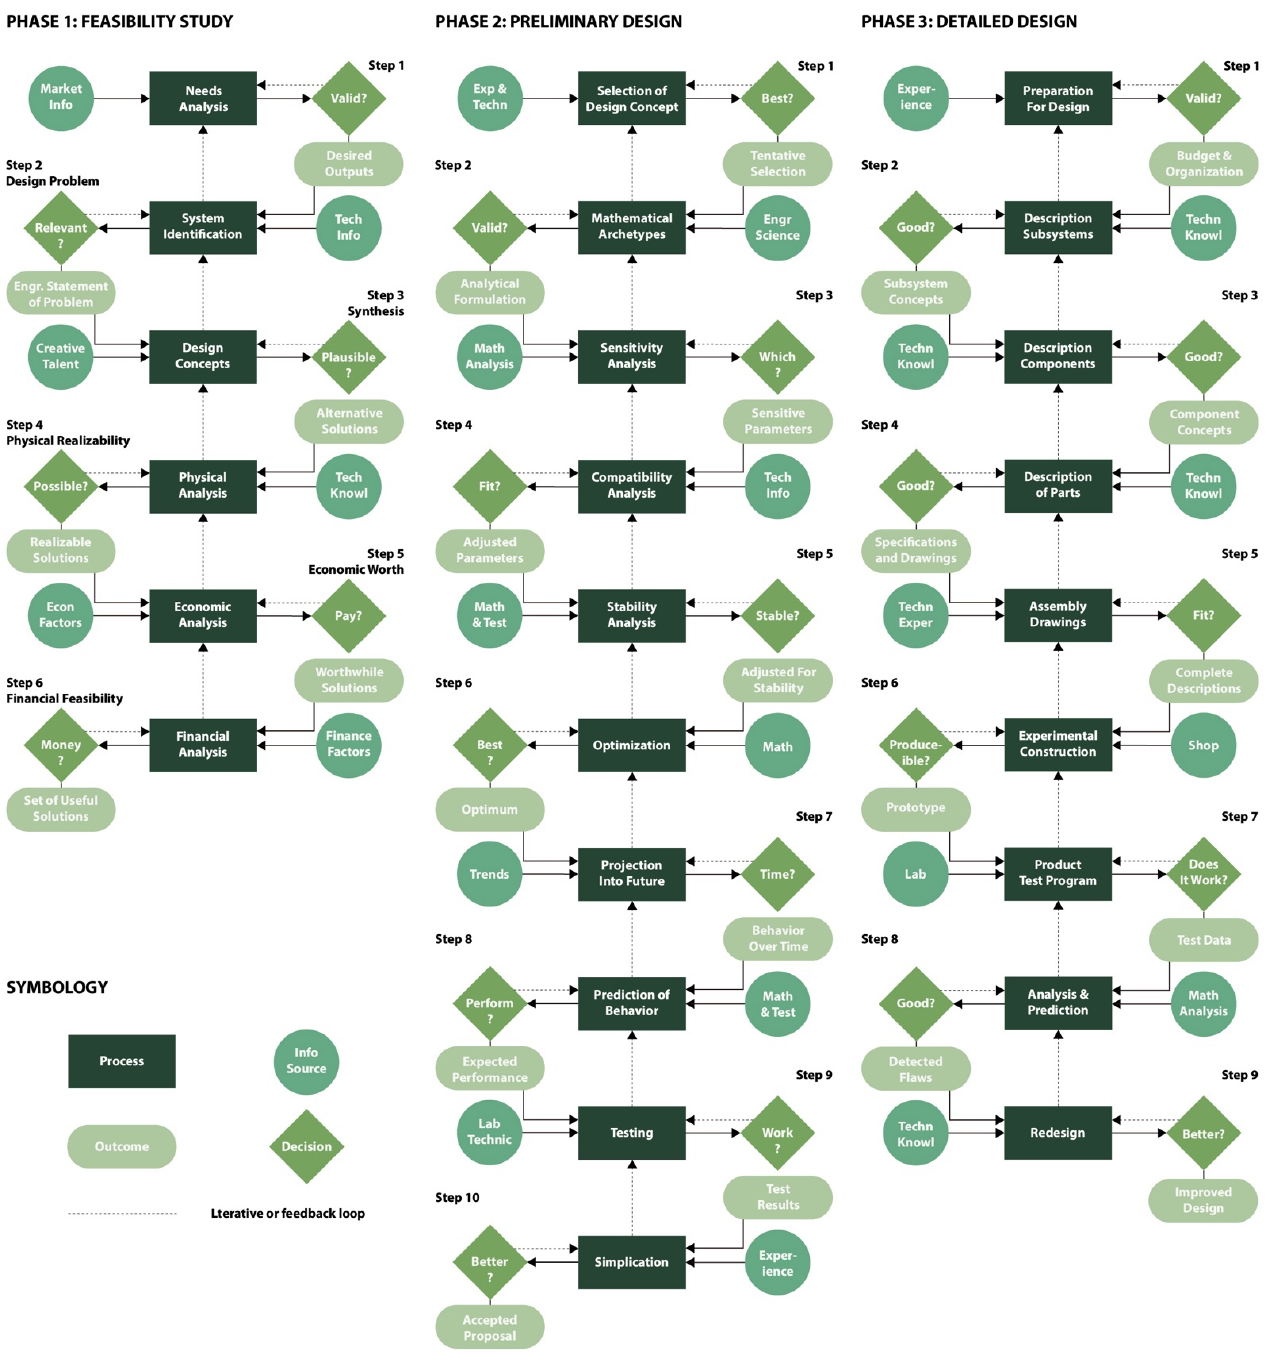
Figure 5. Morris Asimow’s design method process model. (According to ref. [124,129], this figure is painted by this article).